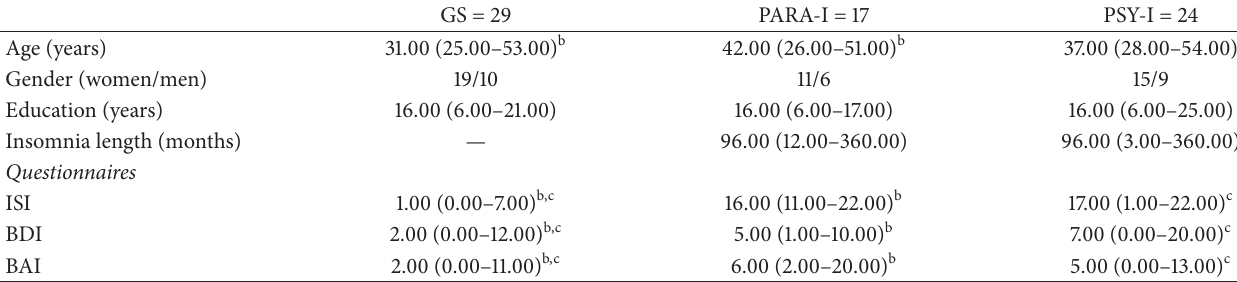
Table 1: Medians (ranges) of sociodemographic data of good sleepers (GS) and paradoxical (PARA-I) and psychophysiological (PSY-I) insomnia sufferers.